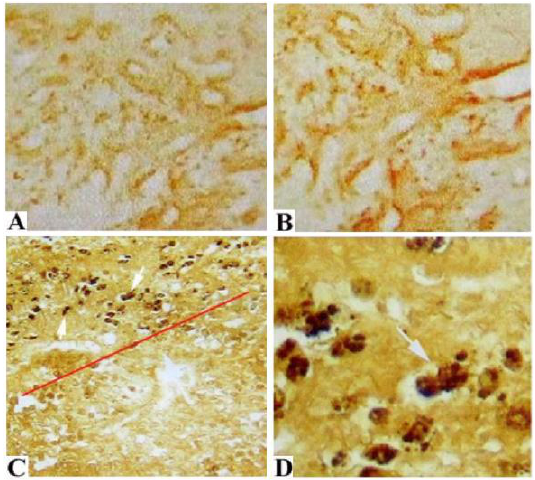
Fig. 3. Immunohistochemical analysis of survivin protein in FFPE blocks: A) Negative control without secondary antibody (×1000; B) Negative control without primary antibody (×1000; C) survivin visualization in cancerous and noncancerous part of a tumor (×400; D) Survivin protein detected in tumor cells (×1000); Line shows the boundary between tumor and margin. Arrows show the location of survivin protein inside